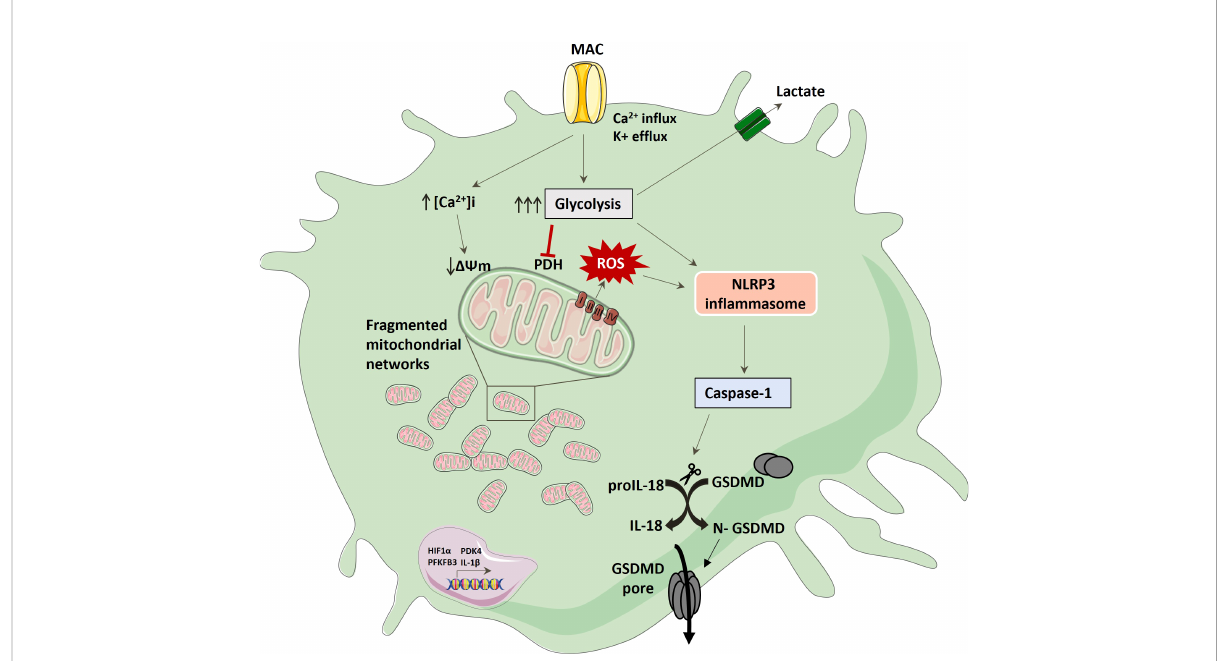
FIGURE 7 Schematic of hMDM response to MAC stimulation; MAC binding drives glycolysis, ion fl ux and mitochondrial dysfunction characterised by increased extracellular lactate, fragmented mitochondrial morphology, collapsed mitochondrial respiration and increased mitochondrial ROS production. This activates NLRP3 which in turn mediates caspase 1 activation with subsequent IL-18 and GSDMD cleavage, providing a conduit for active pro-in fl ammatory cytokine. Longer term changes also include increases in key pathways associated with pro-in fl